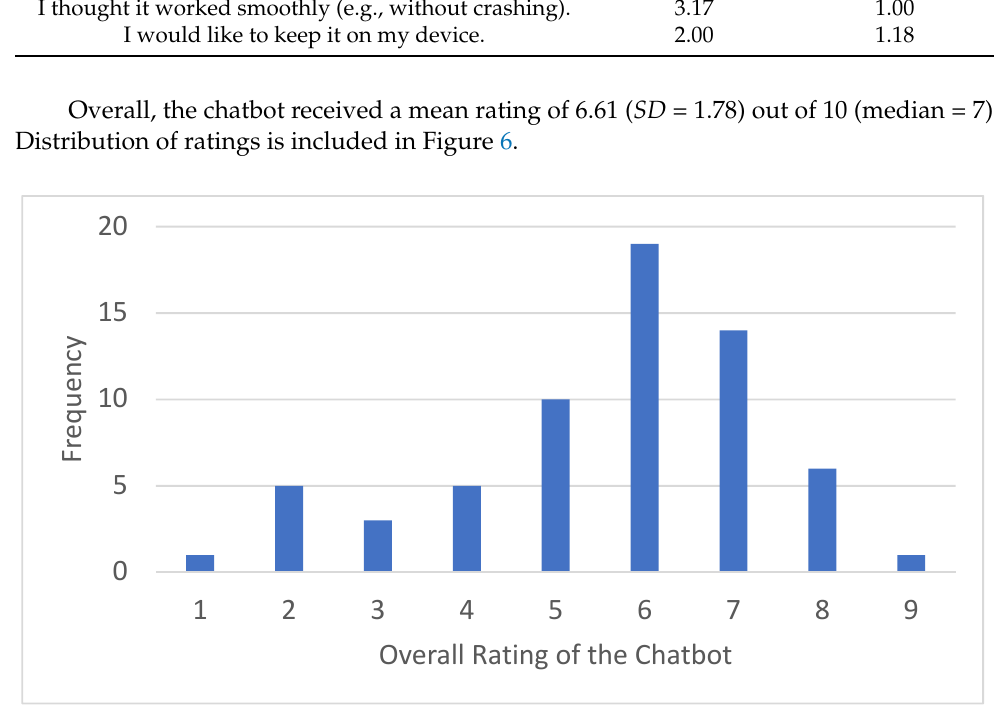
Figure 6. Satisfaction rating post intervention (N=64).